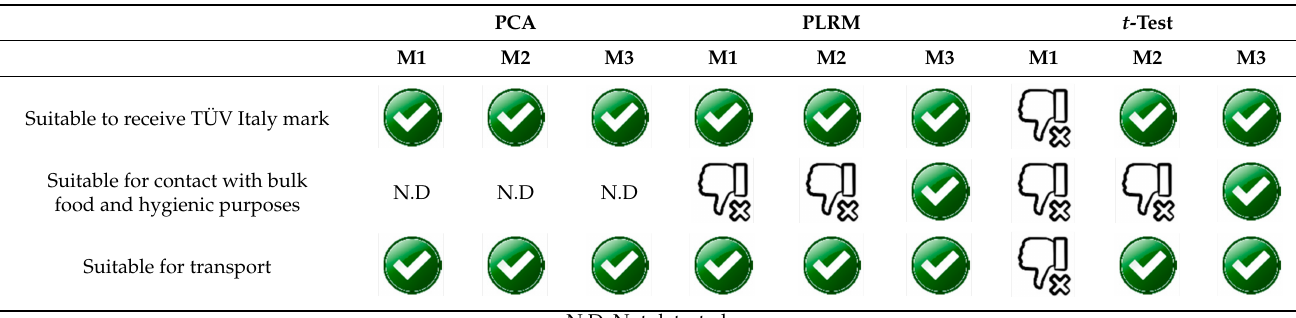
Table 6. Comparison between results from PCA, the PLRM, and the Student t -test. PCA PLRM t -Test M1 M2 M3 M1 M2 M3 M1 M2 M3